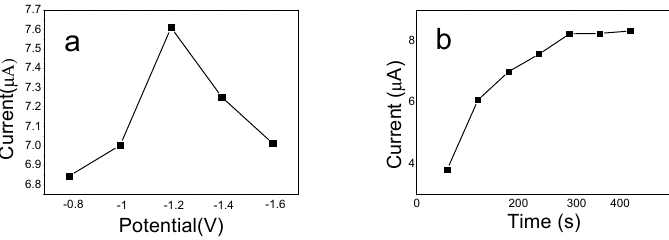
Figure 10. ( a ) Relationship between stripping peak values recorded form SWASV responses and preconcentration potential upon the 10 ng / mL Cd(II) standard solution, ( b ) Relationship between stripping peak values recorded form SWASV responses and preconcentration time upon the 10 ng / mL Cd(II) standard solution.